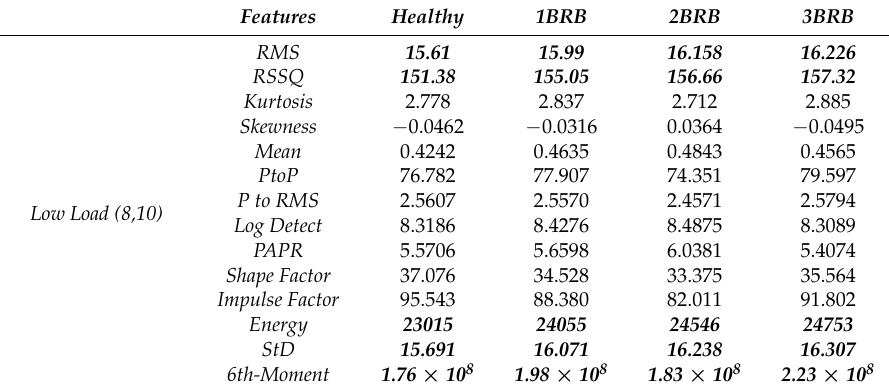
Table 5. Mean Value of Statistical Features for Healthy and Faulty Motor in Low